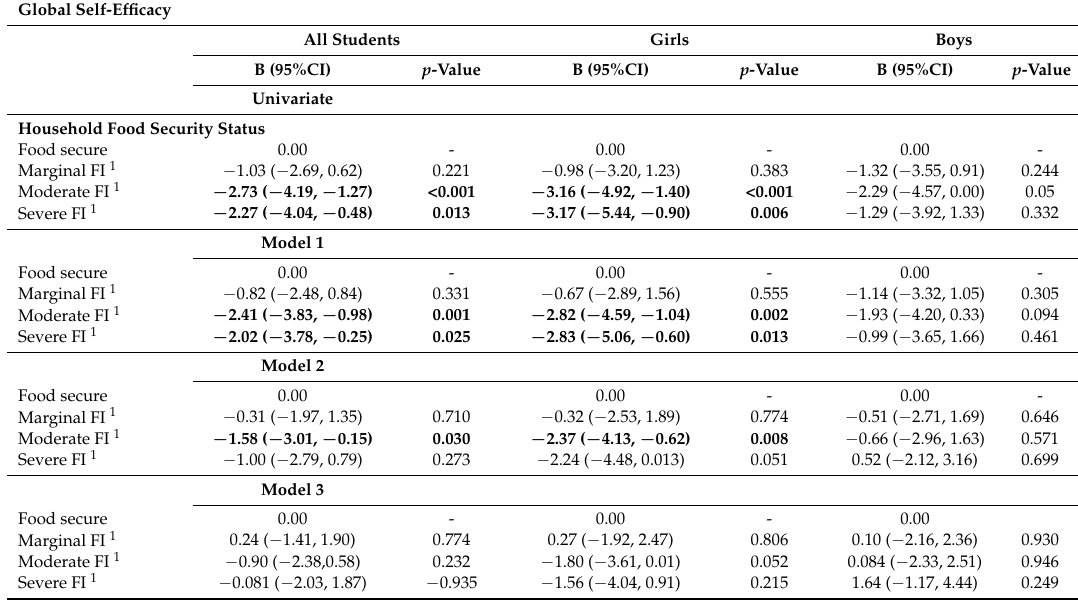
Table 3. Relationship between food insecurity and global self-efficacy to make healthy choices among grade 5 students (aged 10–11 years) in Nova Scotia,